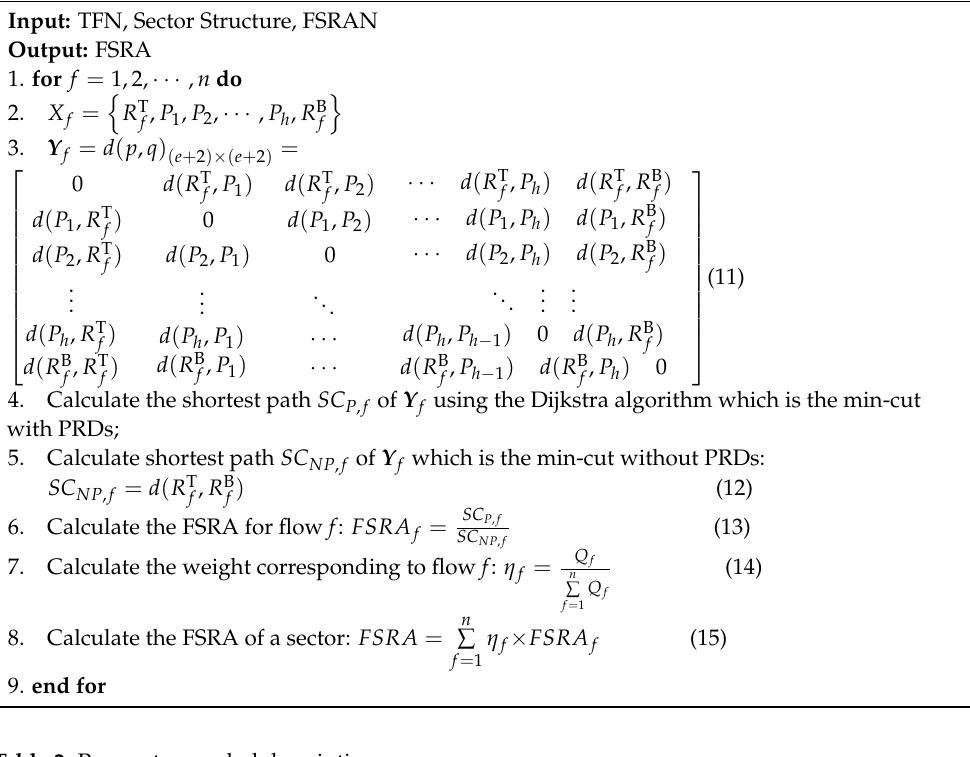
Algorithm 2. The whole FSRA calculation